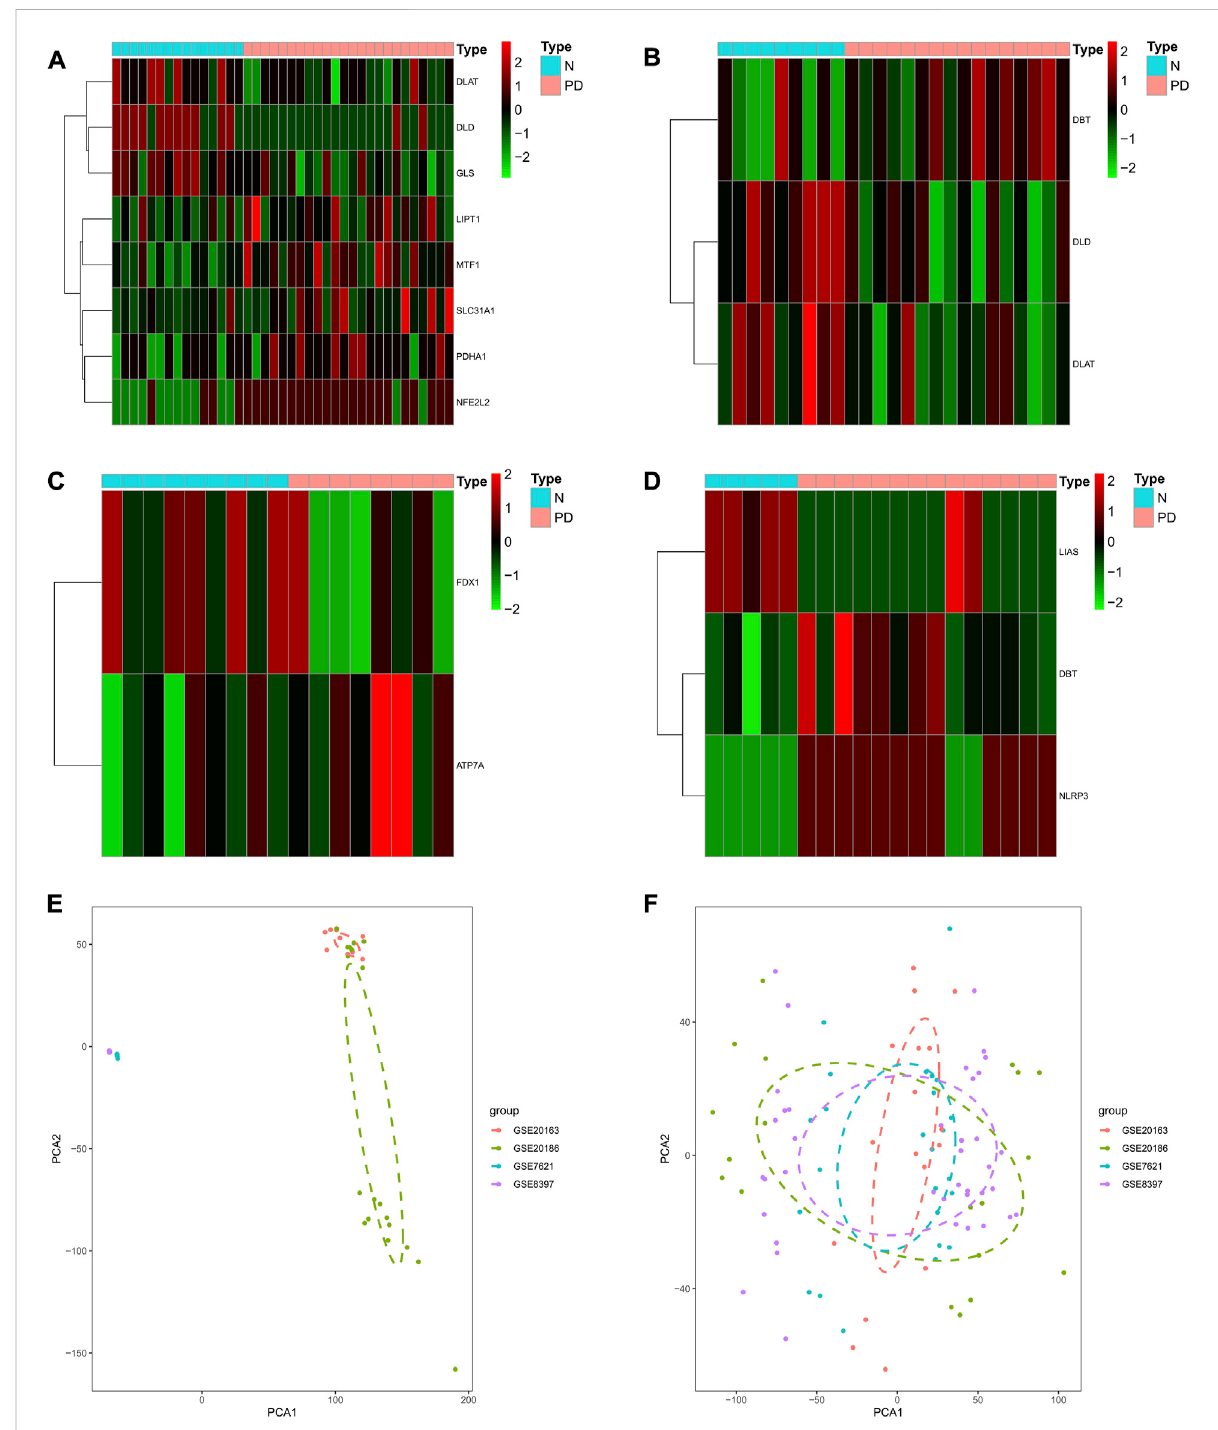
FIGURE 1 Identi fi cation of Parkinson ’ s onset and cuprotosis-related genes in the combined expression pro fi le of the GEO cohort. (A – D) Heat map showing differentially expressed CRGs for the GSE8397, GSE7621, GSE20163, and GSE20186 cohorts. (E) PCA plot showing the combinatorial expression pro fi le of the GEO cohort. (F) PCA plot showing the combined expression pro fi le of the GEO cohort after batch